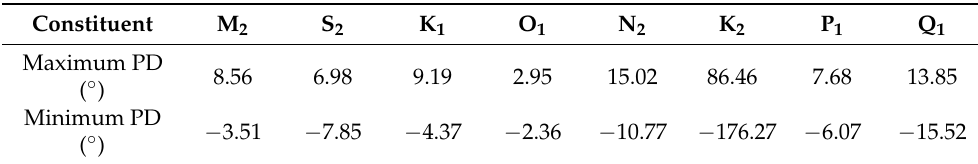
Figure 7. Histogram of the phase difference before and after MVC of the eight tides in the South China Sea. Table 7. Extreme values of the phase difference (PD) before and after MVC of the eight major constituents in the South China Sea.